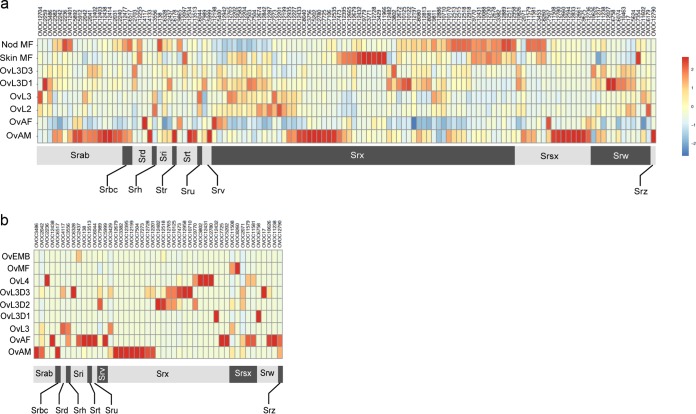
O. volvulus stage-specific expression of G protein-coupled receptors (GPCRs). Shown are heat maps depicting the stage-specific expression of GPCRs in O. volvulus ordered by family. Values plotted are the z scores of RPKM (a) and normalized spectral abundance factors of proteins (b). Red to blue denotes high to low expression, as shown on the scale to the right.